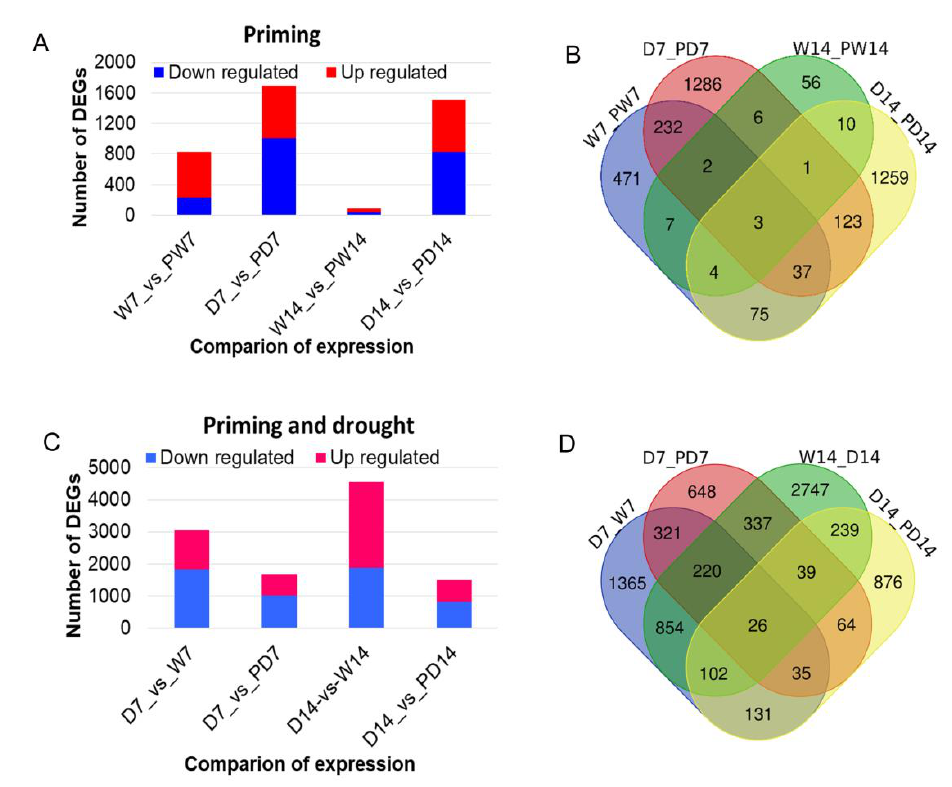
Figure 5. Di ff erentially expressed genes induced by brassinolide priming in peanut leaves under well-watered and drought conditions. ( A ) The number of DEGs induced by BR priming; ( B ) Venn graph showing the common and specific DEGs induced by BR priming; ( C ) The number of DEGs induced by combined BR priming and drought; ( D ) Venn graph showing common and specific DEGs induced by combined drought and BR priming. D7_vs_w7: comparison between 7 days of drought and 7 days of well-watered condition; D7_vs_PD7: comparison between 7 days of drought and combination priming and 7 days of drought; D14_vs_w14: comparison between 14 days of drought and 14 days of well-watered condition; D14_vs_PD14: comparison between 14 days of drought and combination priming and 14 days of drought.